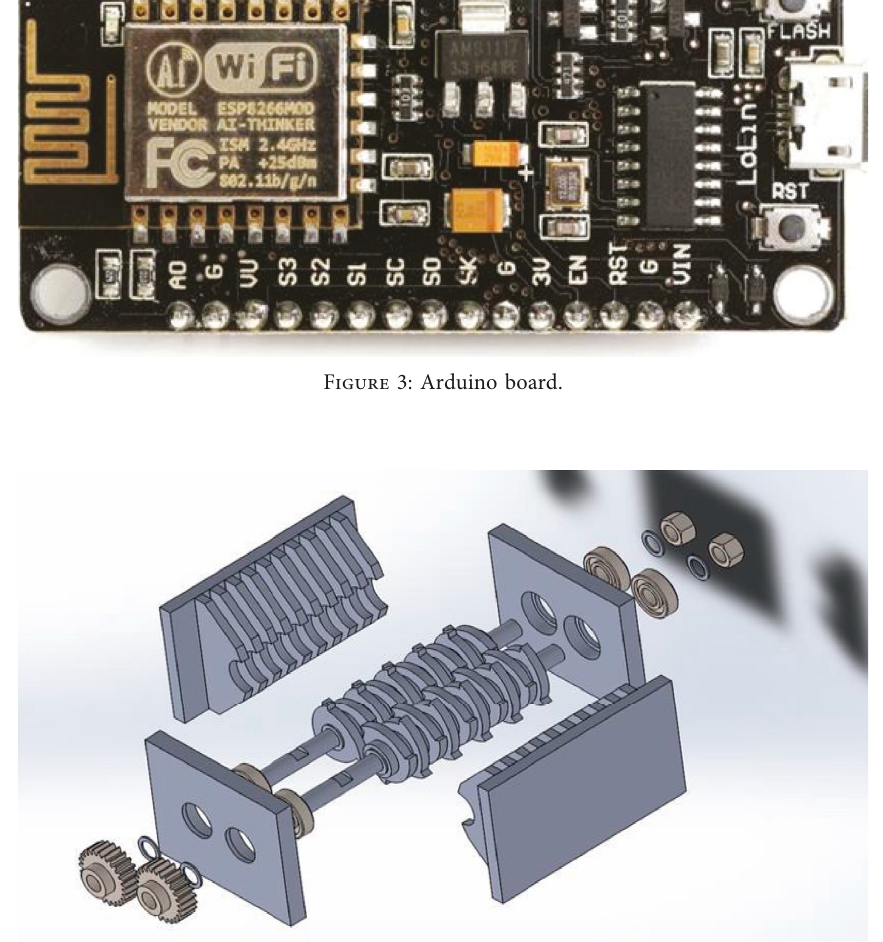
Figure 4: Node MCU ESP8266.